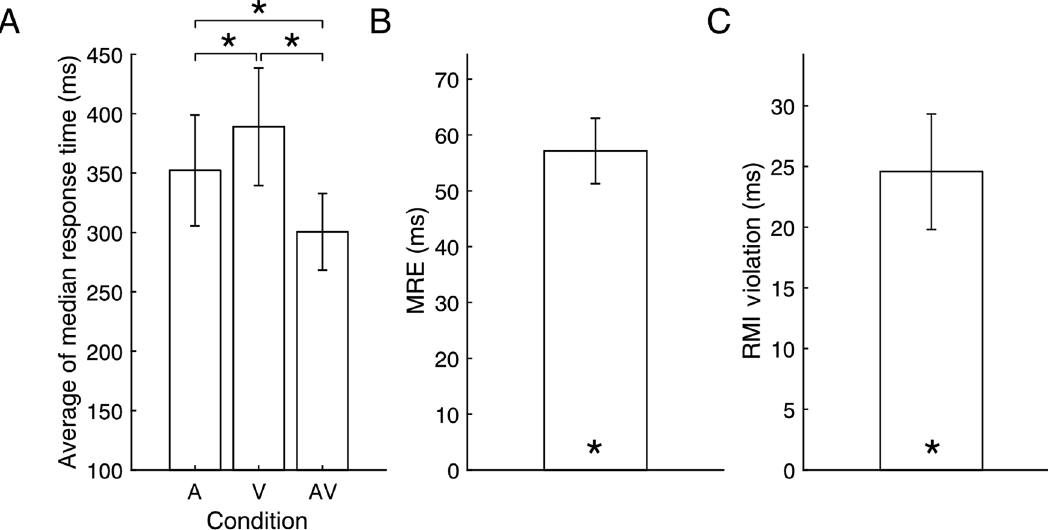
Figure 4. ( A ) The average of the median response times in the auditory (A), visual (V), and audiovisual (AV) condition in Experiment 2. ( B ) Multisensory response enhancement. ( C ) Race model inequality violation. ( D ) Error bars indicate standard errors. Asterisks indicates BF 10 >